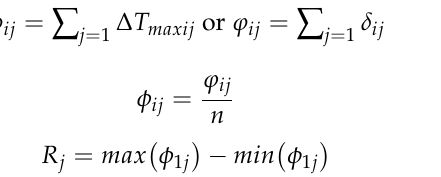
Table 6. Operational conditions of the parameters.